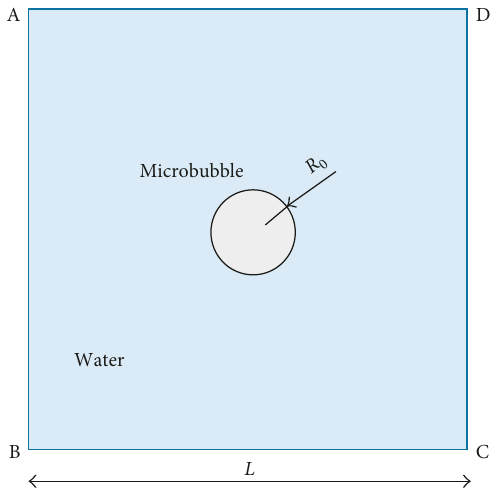
Figure 1: Simulation domain of a single microbubble in an ul- trasound